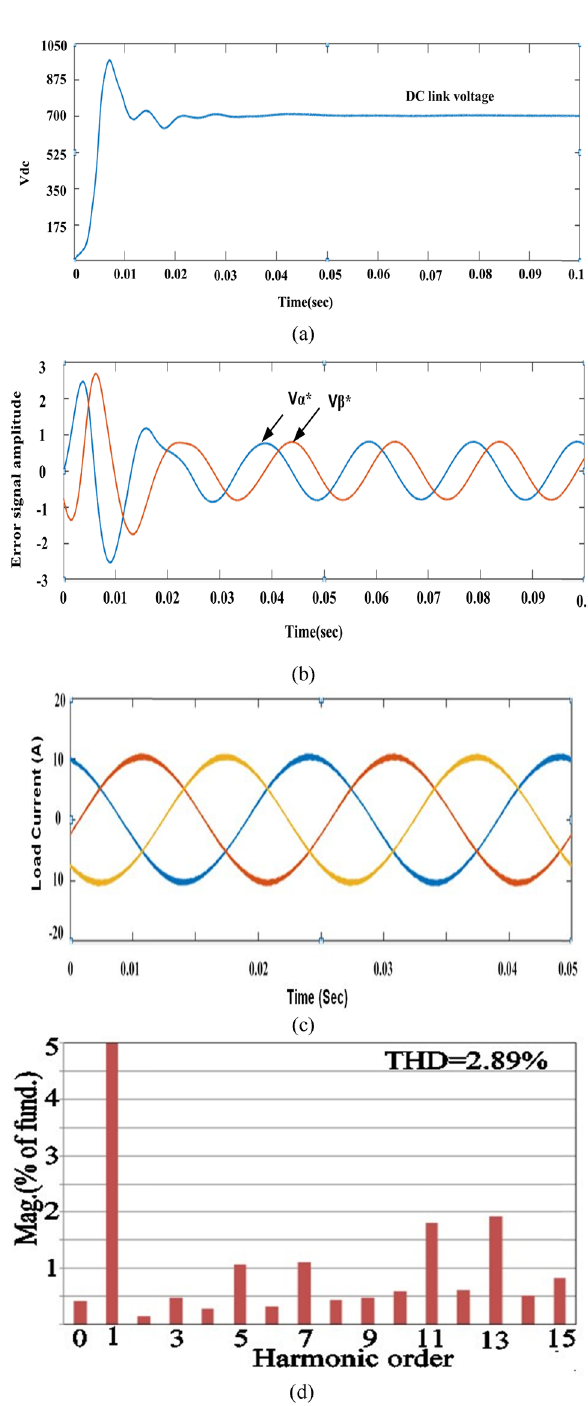
Figure 7: Results for synchronous reference frame: ( a ) DC - link vol - tage, ( b ) error signal, ( c ) inverter output current, and ( d ) THD of output current.